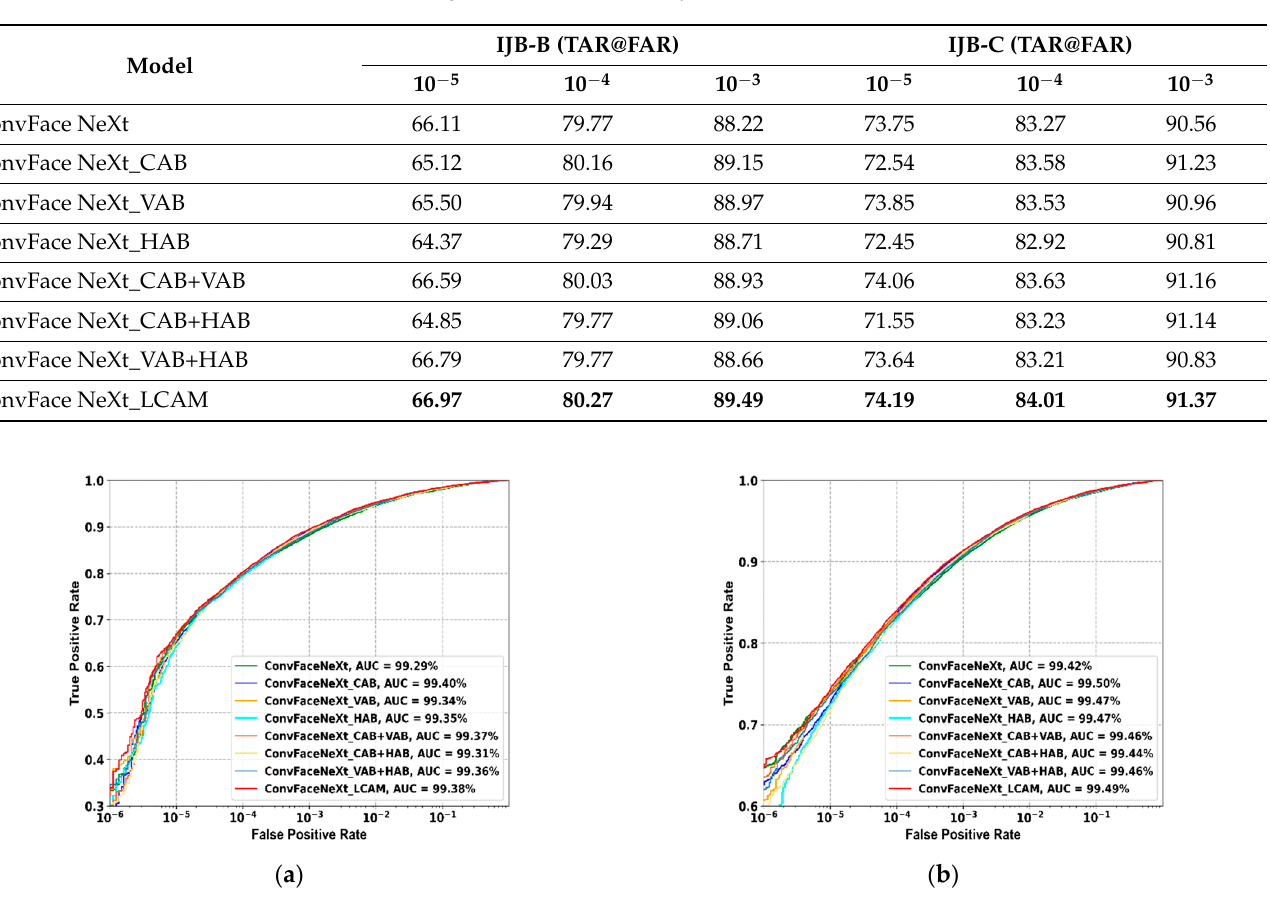
Figure 6. ROC curves on di ff erent combination of branches. ( a ) IJB-B dataset; ( b ) IJB-C dataset.